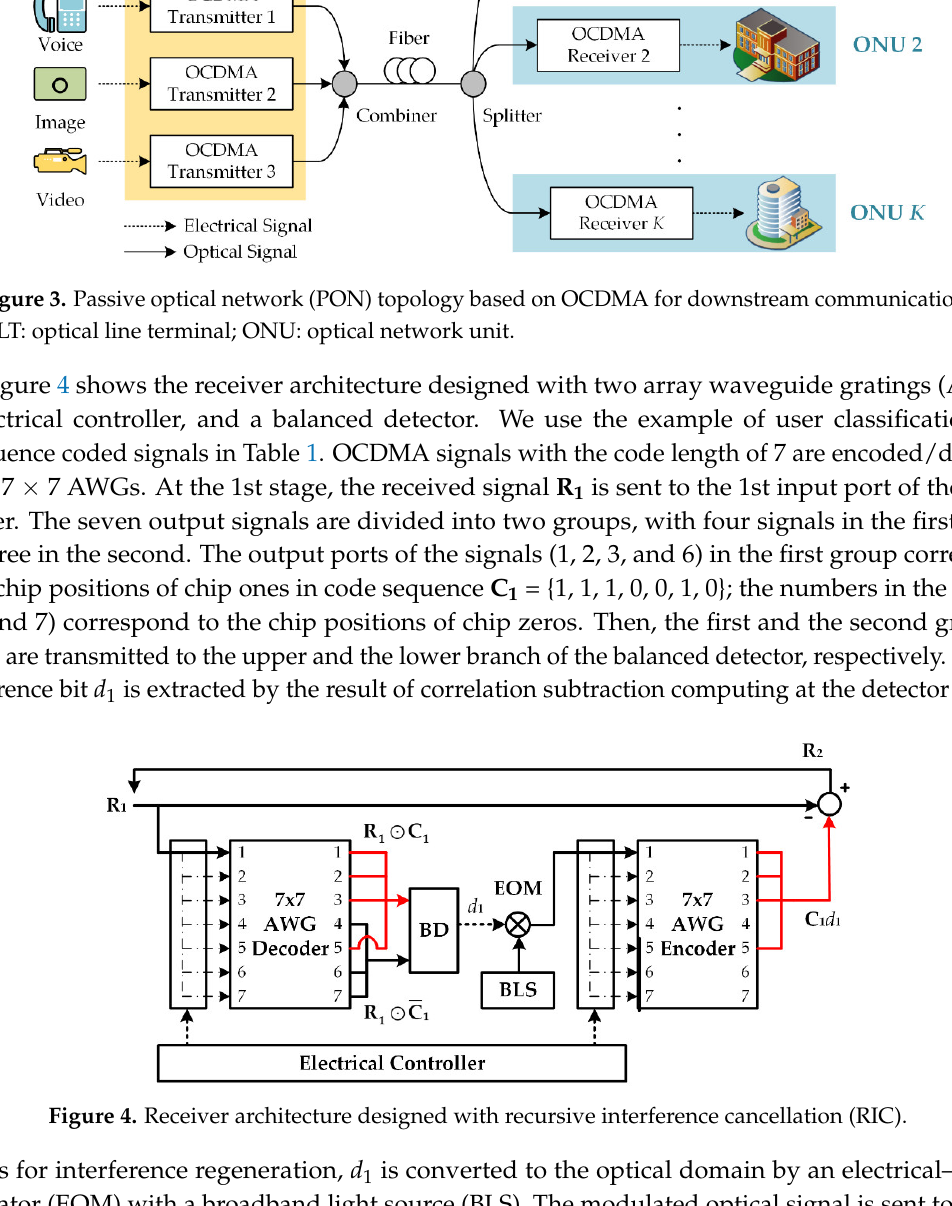
Figure 5. Spectral distributions of M-sequence code C 1 in the process of ( a ) decoding and ( b ) encoding, based on array waveguide grating (AWG) structure.